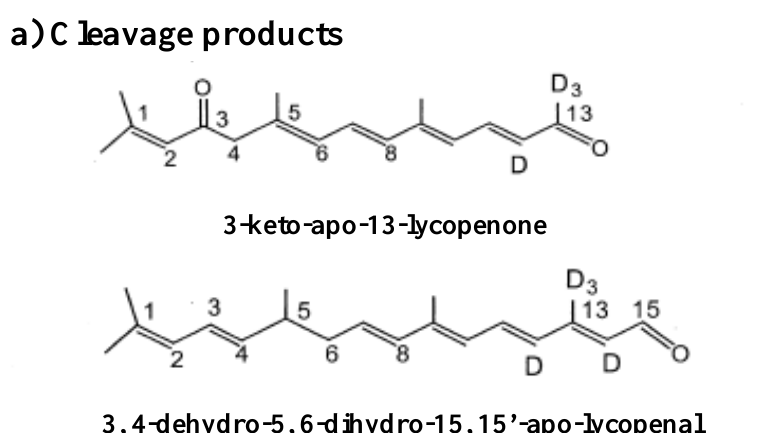
Figure 2. Proposed structures of the metabolites